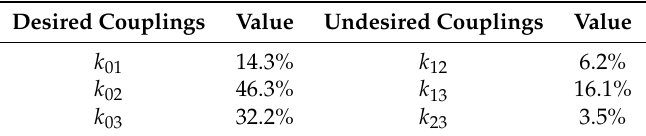
Table 2. Coupling factors of the analyzed example.